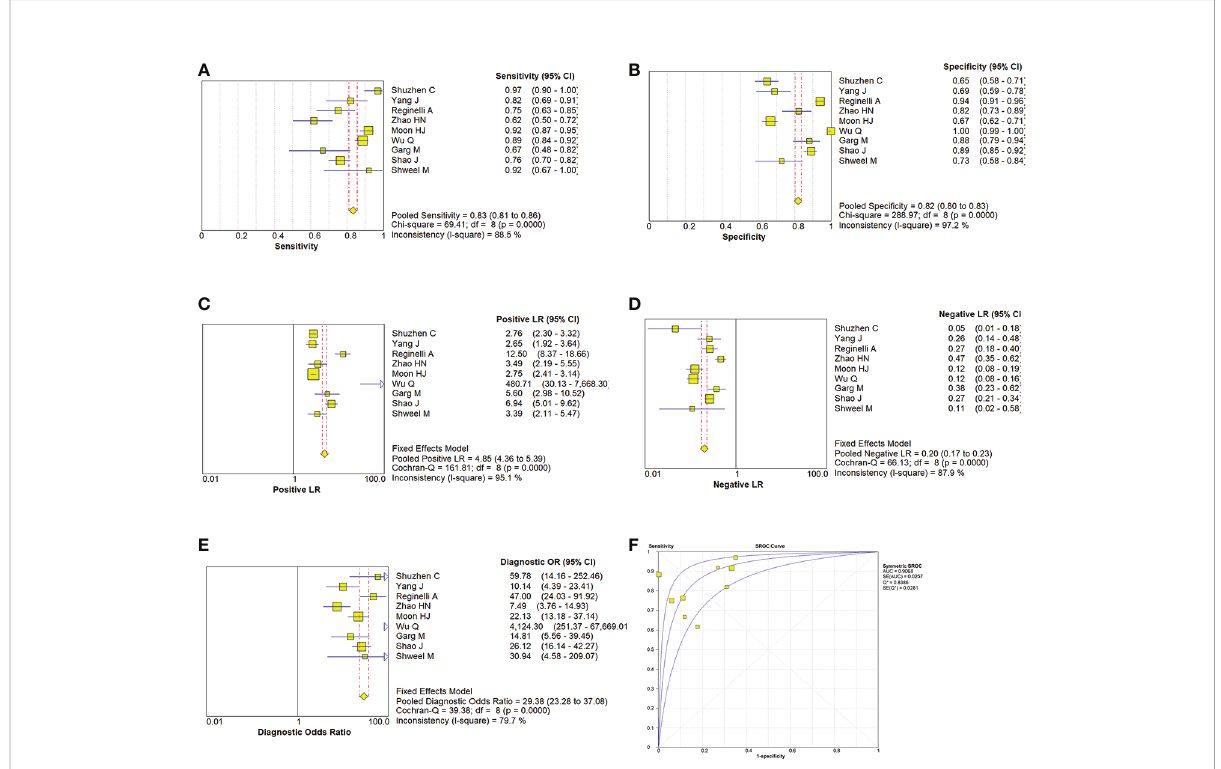
FIGURE 5 Estimates of conventional ultrasonography assessment for the diagnosis of malignancy thyroid nodules (A – E) Forest plots illustrate pooled estimates (diamonds) for sensitivity (A) , speci fi city (B) , positive likelihood ratio (LR) (C) , negative LR (D) , and diagnostic odds ratio (E) and corresponding 95% CIs for pooled estimates. (F) Summary receiver operating characteristic (SROC) plot for assessing accuracy with corresponding curves indicative of upper and lower bounds of 95% CI. AUC = area under curve, SE = standard error, Q* = summary measure of accuracy derived from the SROC